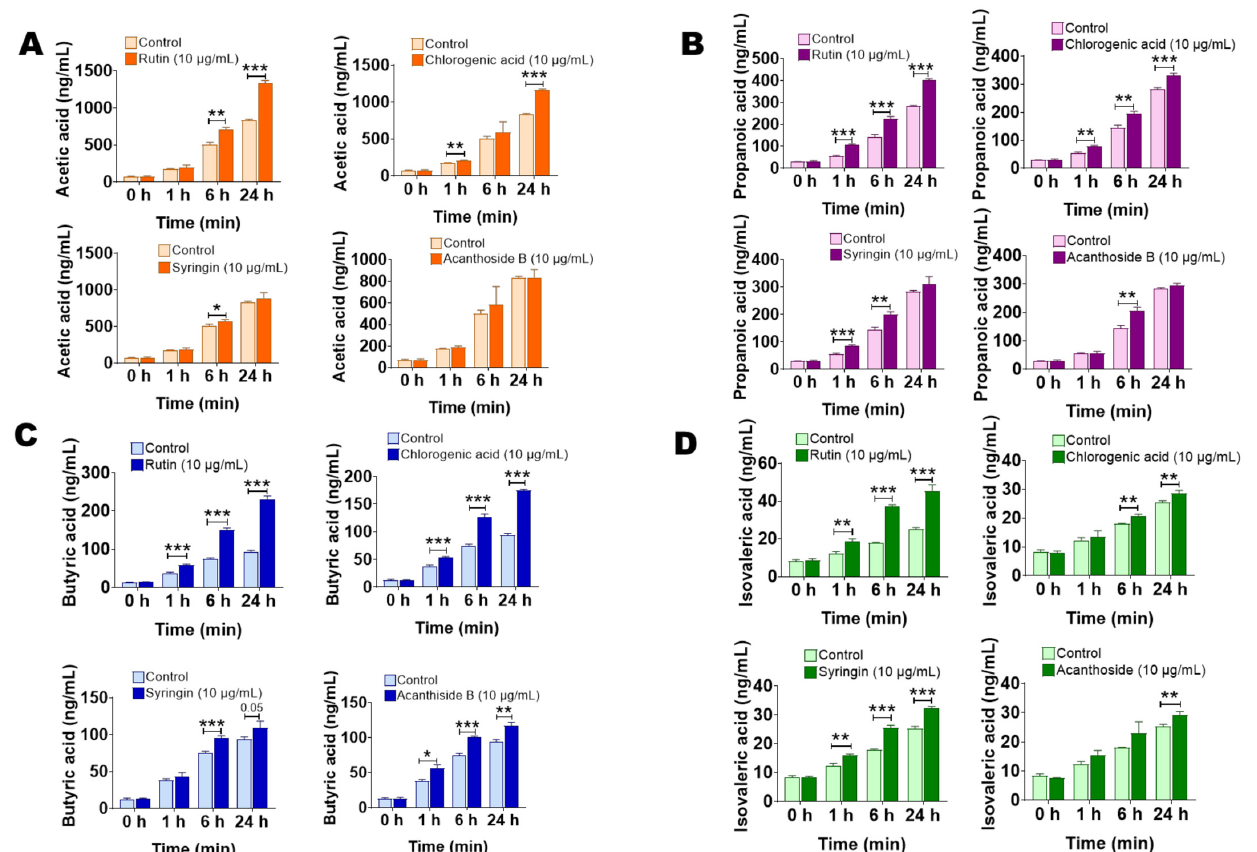
Figure 6. The four main components of Saussurea involucrata (chlorogenic acid, syringin, acanthoside B, rutin) stimulated intestinal bacteria to produce short chain fatty acids ( n = 3). ( A ) Acetic acid; ( B ) propionic acid; ( C ) butyric acid; ( D ) isovaleric acid. Data are presented as mean ± SD, and two-tailed Student’s t test was used for analysis (*** p < 0.001, ** p < 0.01, * p <